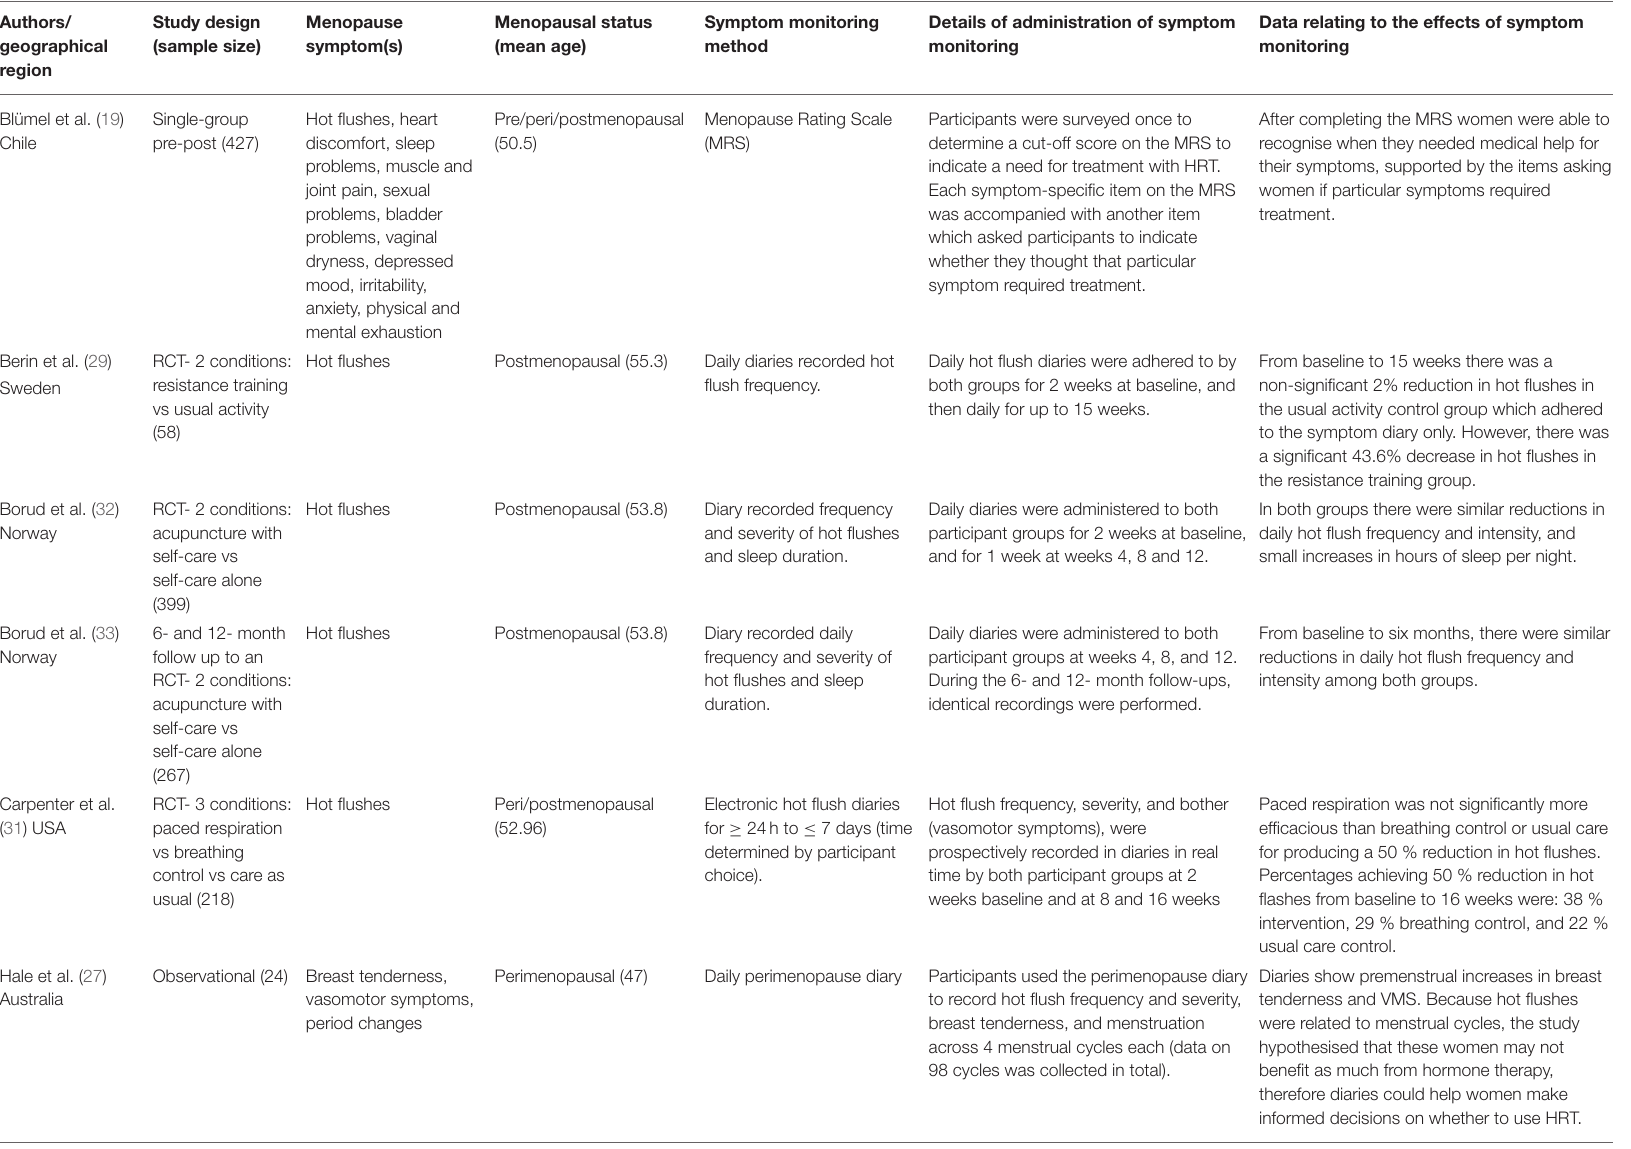
TABLE 1 | Visual summary of study